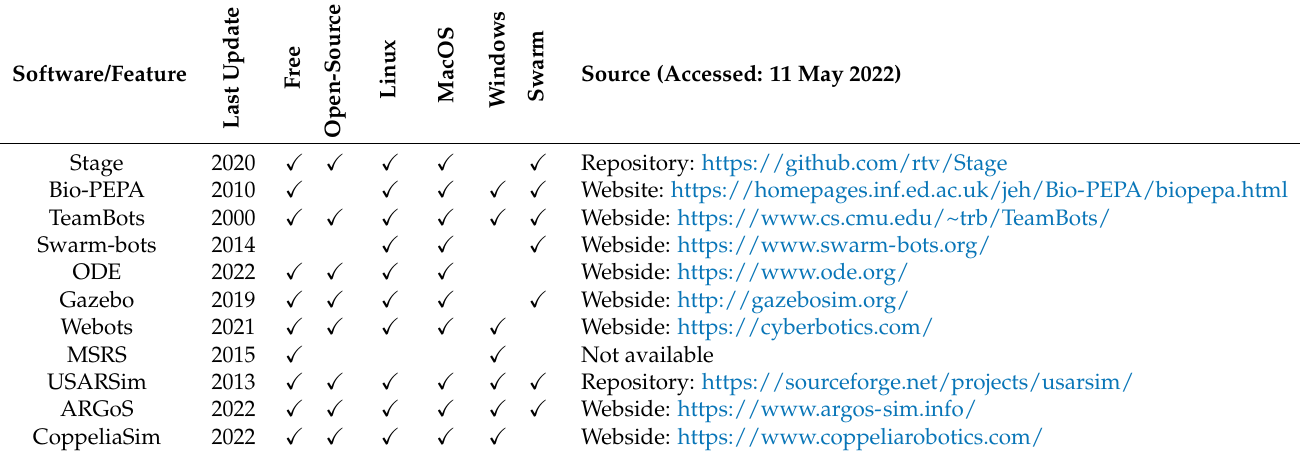
Table 1. Features of most used simulation